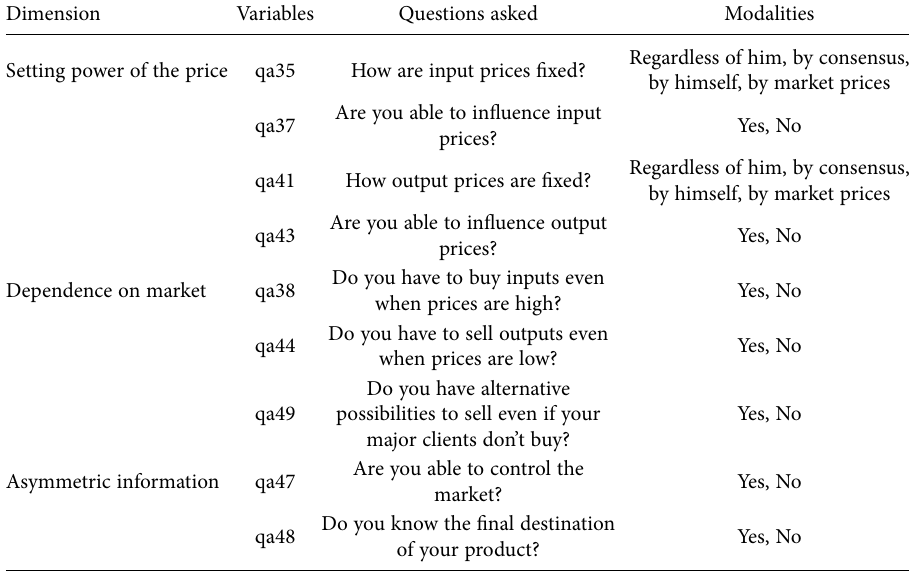
Table 1. Procedures for determining the level of influence of value-chain actors. Dimension Variables Questions asked